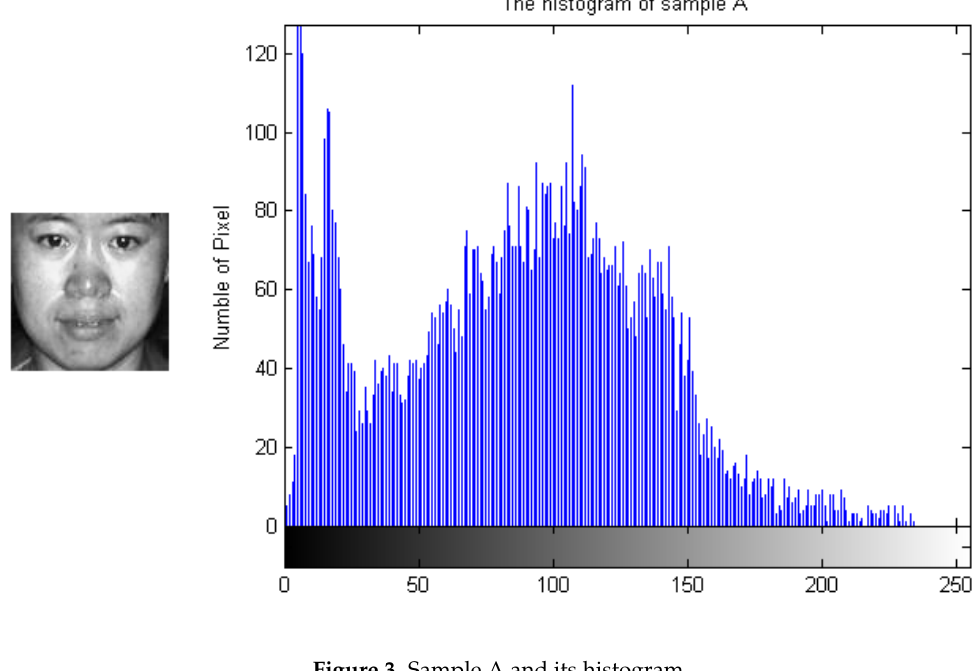
Figure 3. Sample A and its histogram.